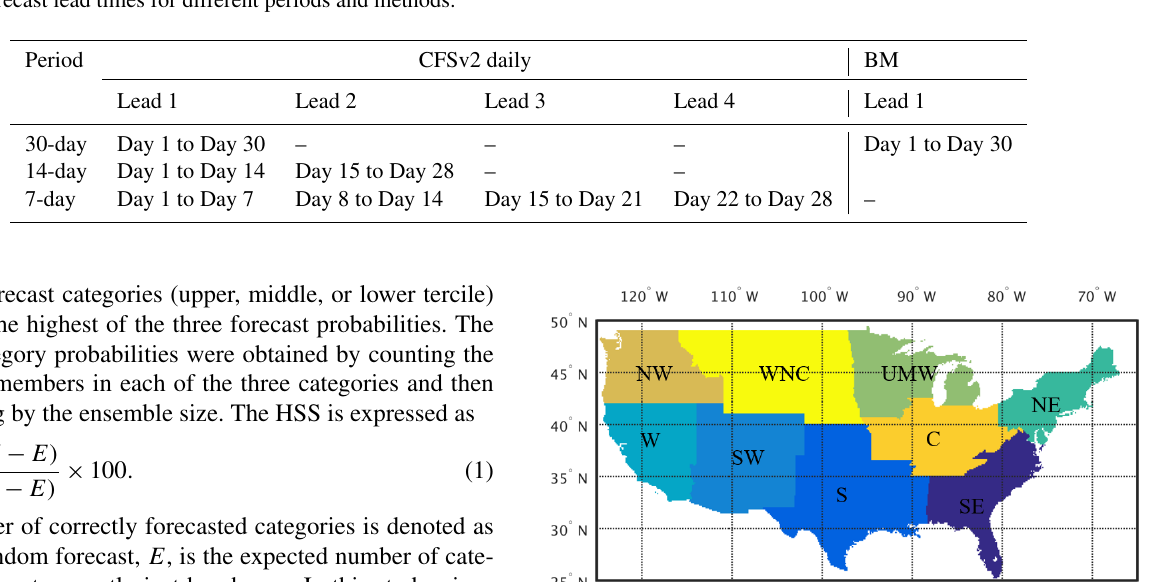
Figure 1. Three configurations of the CFSv2 hindcast: 9-month run, 1 season run, and 45-day run. UTC stands for Coordinated Universal Time. Table 2. Forecast lead times for different periods and methods.